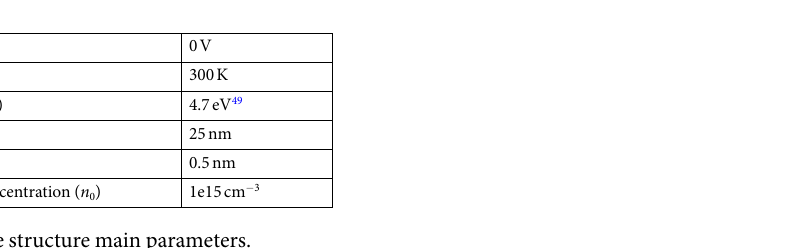
Figure 2. Polarisation charges considerations and related band diagram. ( a ) GaN/AlN/AlGaN/TiN stack showing the different interface charges (fixed and mobile) found at each heterojunction. ( b ) Reference structure computed conduction band profile employing the MOS analogy.